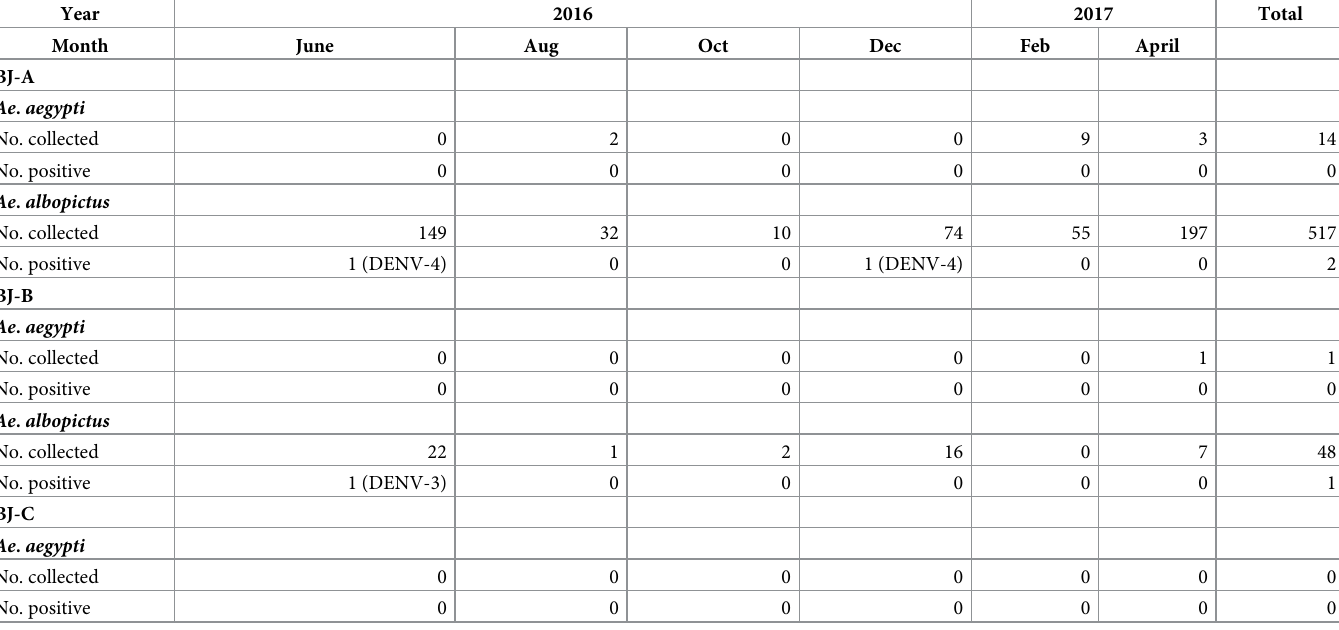
Table 3. DENV detected in Aedes larvae collected in Kuala Lumpur from June 2016 to April